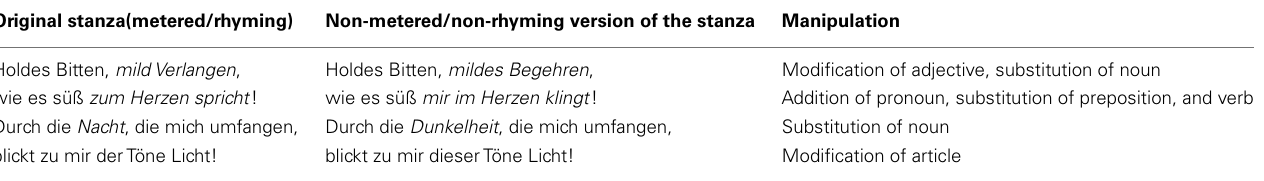
Table 2 | Example for the modification of meter and rhyme in the stimulus material (Brentano, 1803: Abendständchen ). Original stanza(metered/rhyming) Holdes Bitten, mild Verlangen ,